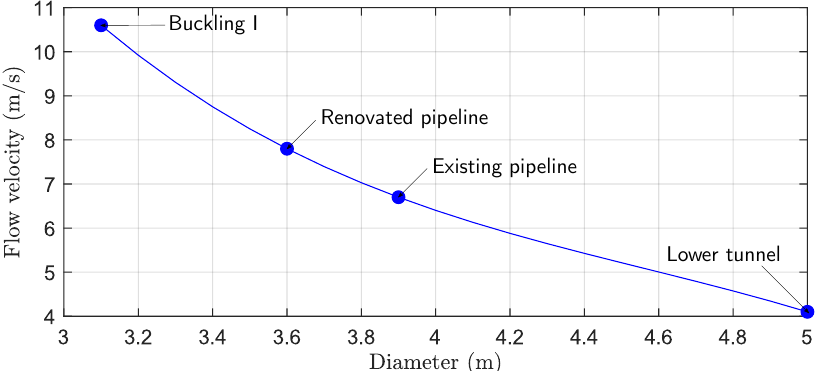
Figure 10. Flow velocity and diameter at different sections of the headrace